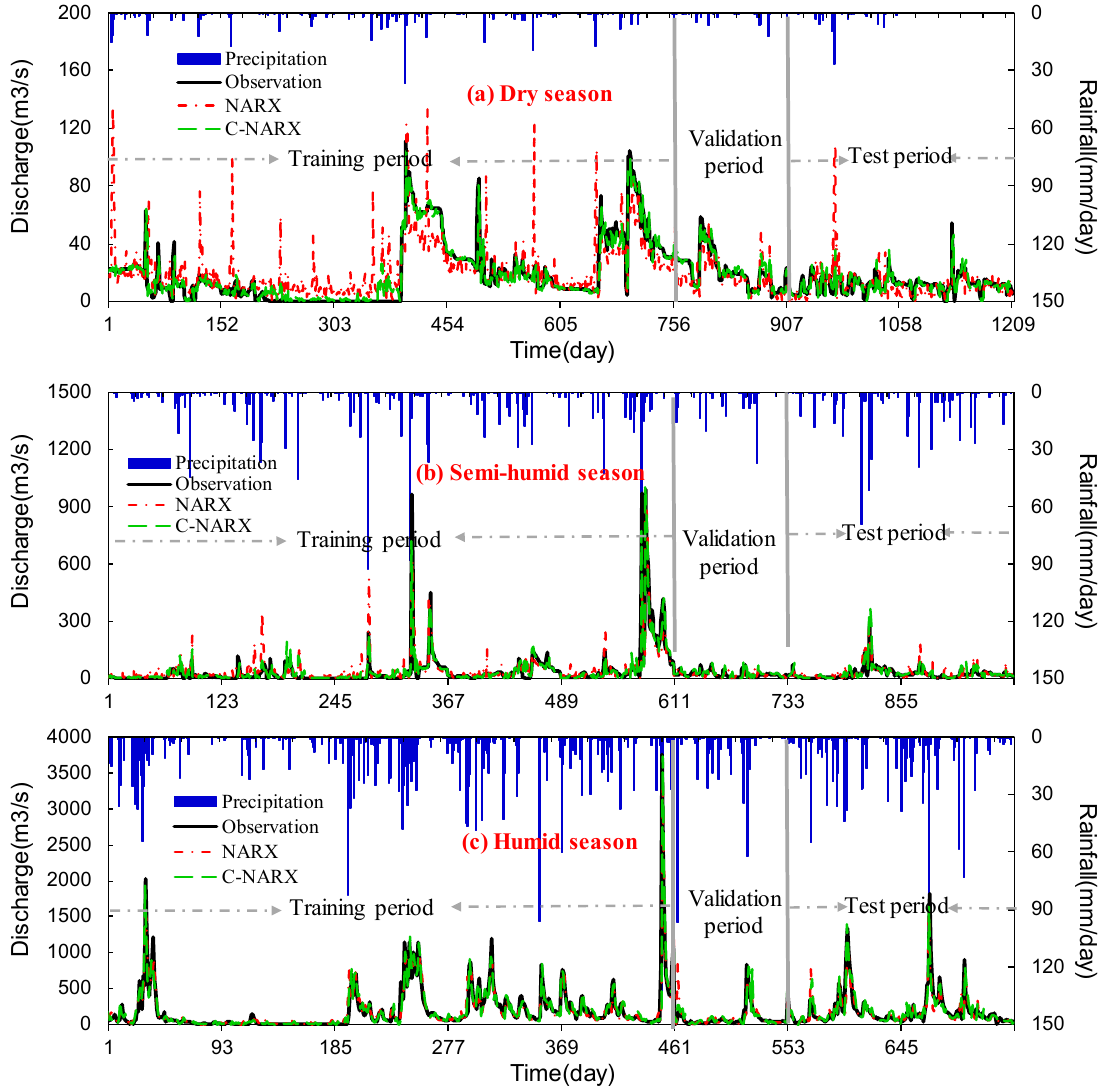
Figure 4. Discharge results based on the NARX and C-NARX models in the ( a ) dry season, ( b ) semi-humid season and ( c ) humid season